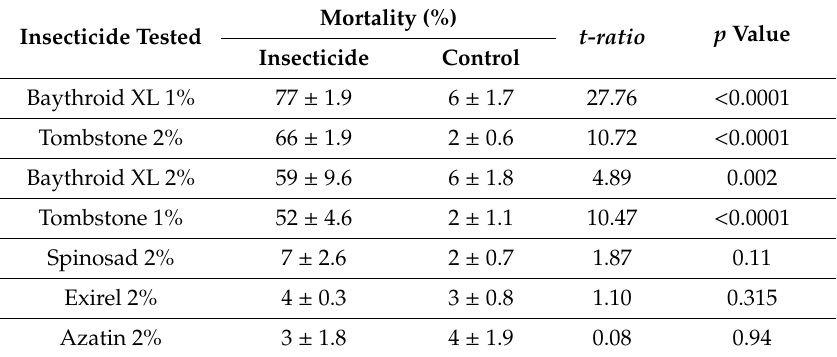
Table 1. Mean ( ± SEM, n = 3) mortality of Diaphorina citri after 4 h exposure to insecticides in SPLAT. Data analyzed by paired t -test, df = 6 ( α =